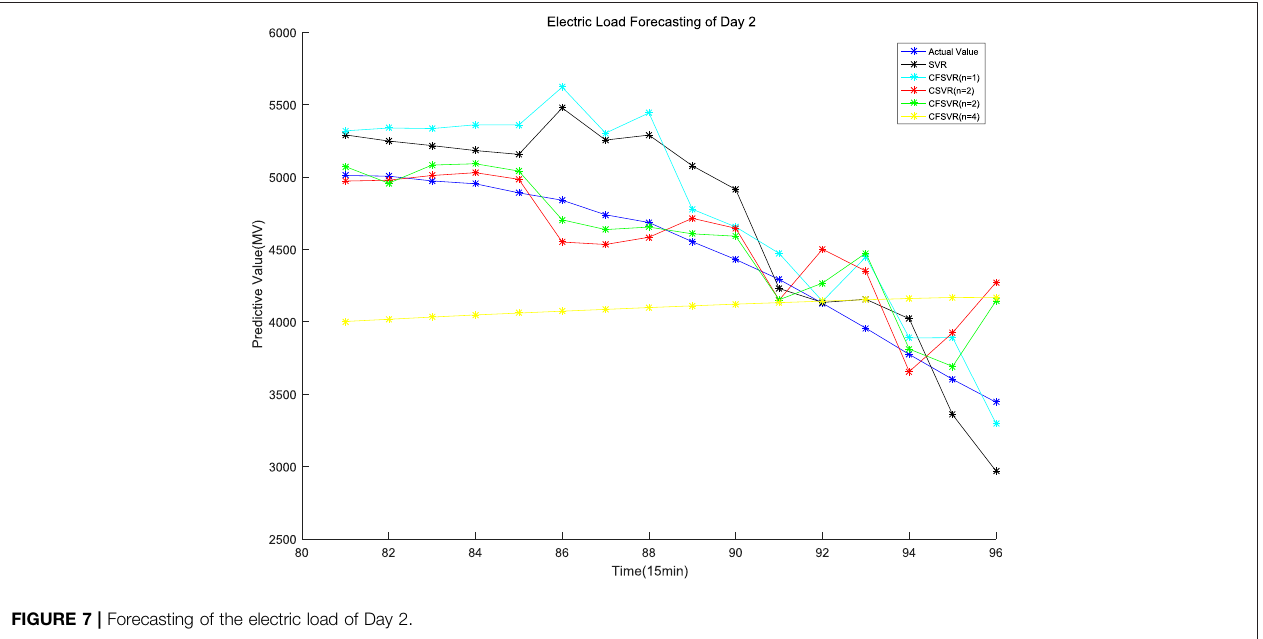
FIGURE 7 | Forecasting of the electric load of Day 2.